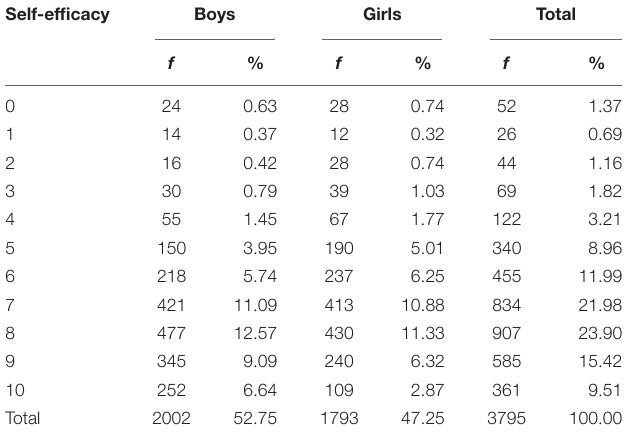
TABLE 5 | Self-efficacy in completing the test battery by sex. Self-efficacy